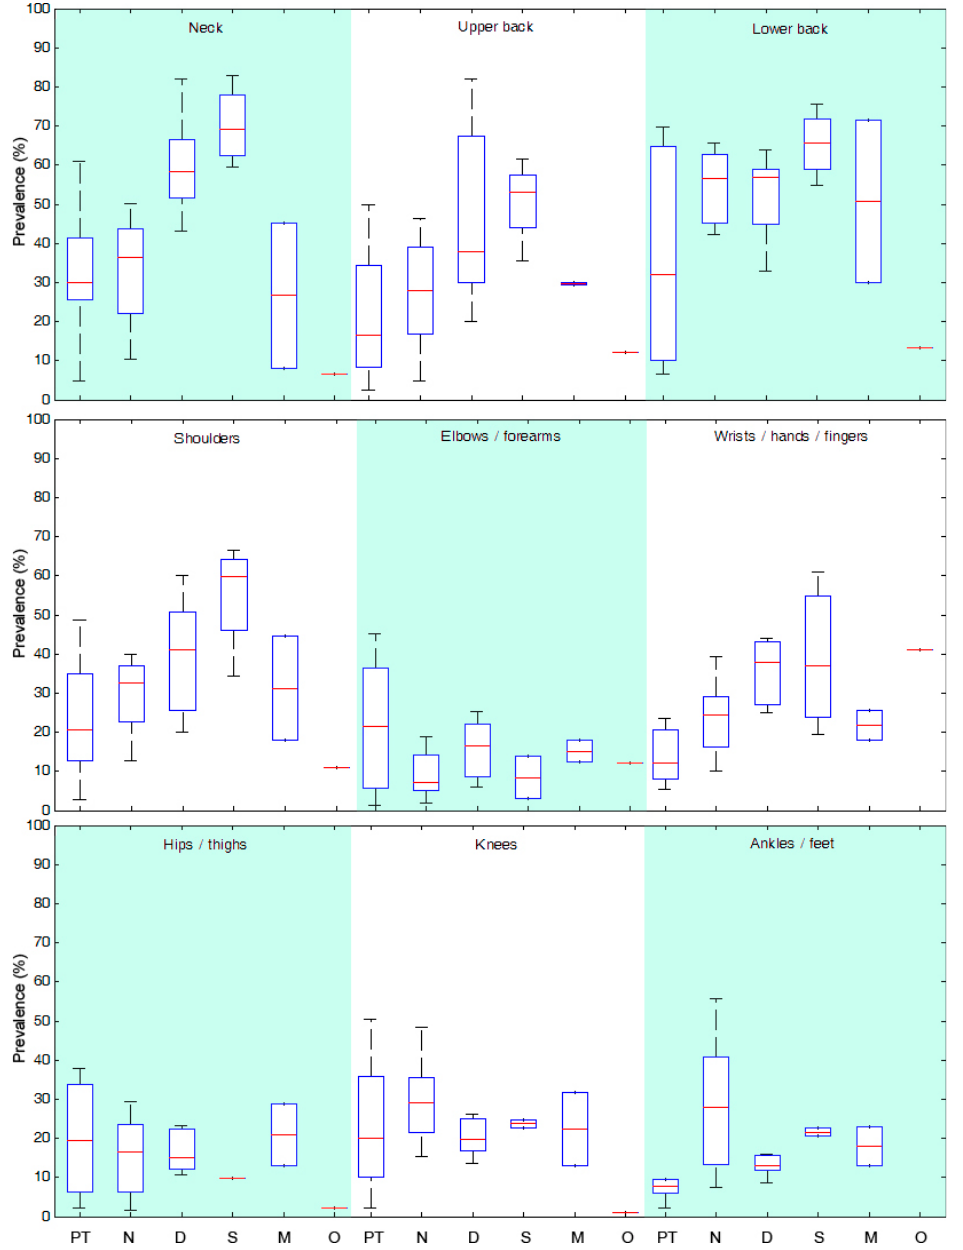
Figure 2. Synthesis of MSD prevalence by body area for each healthcare profession. Boxplots represent lower, median and upper quartile values. Whiskers correspond to the most extreme values within 1.5 times the interquartile range. PT = Physiotherapists/Physical therapists; N = Nurses; D = Dentists; S = Surgeons; M = Midwives; O =